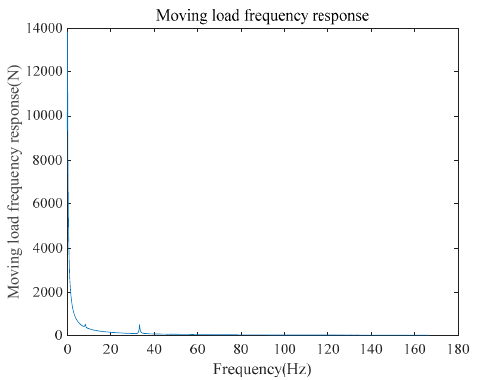
Figure 10. Moving load frequency response.